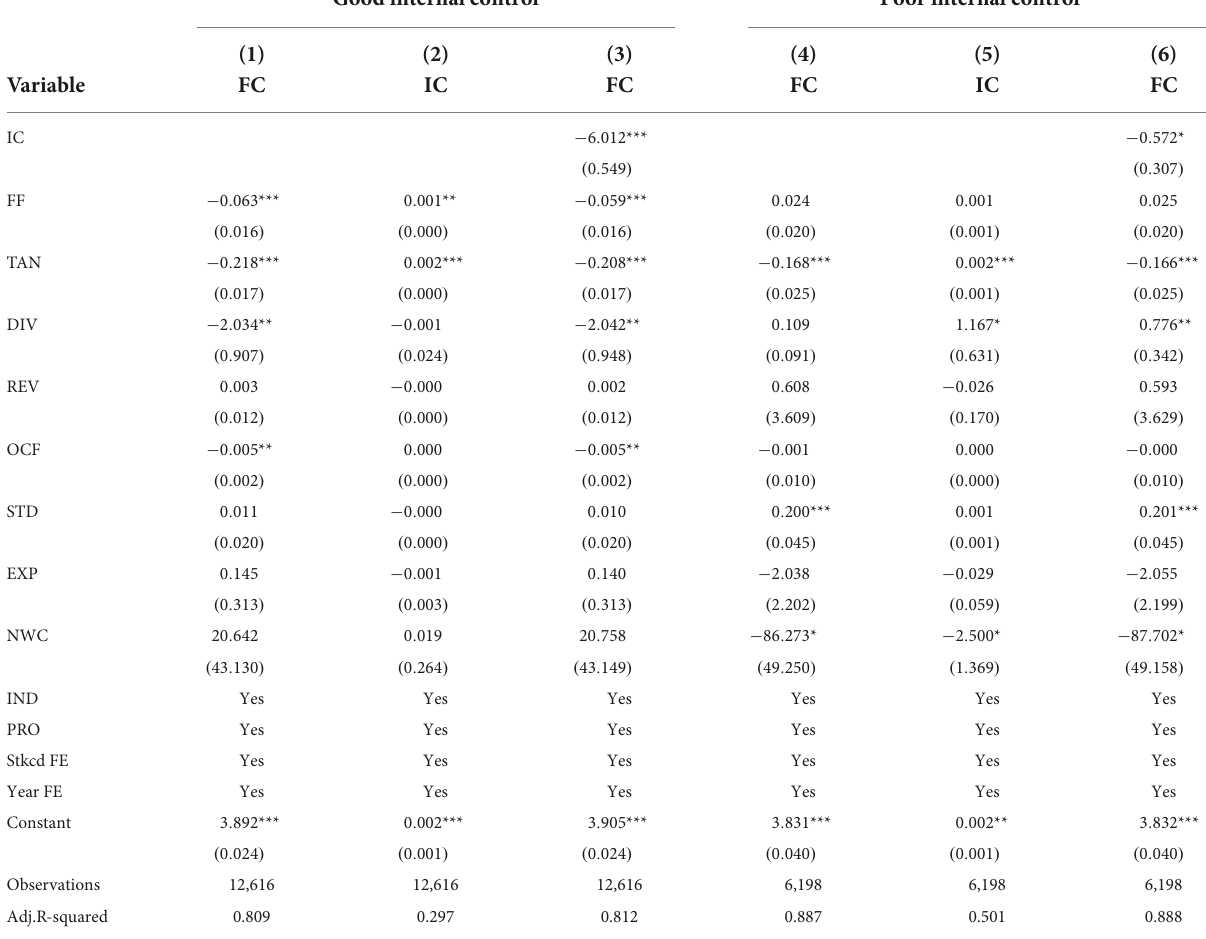
TABLE 6 Financial flexibility and financing constraints: grouped by internal control. Good internal